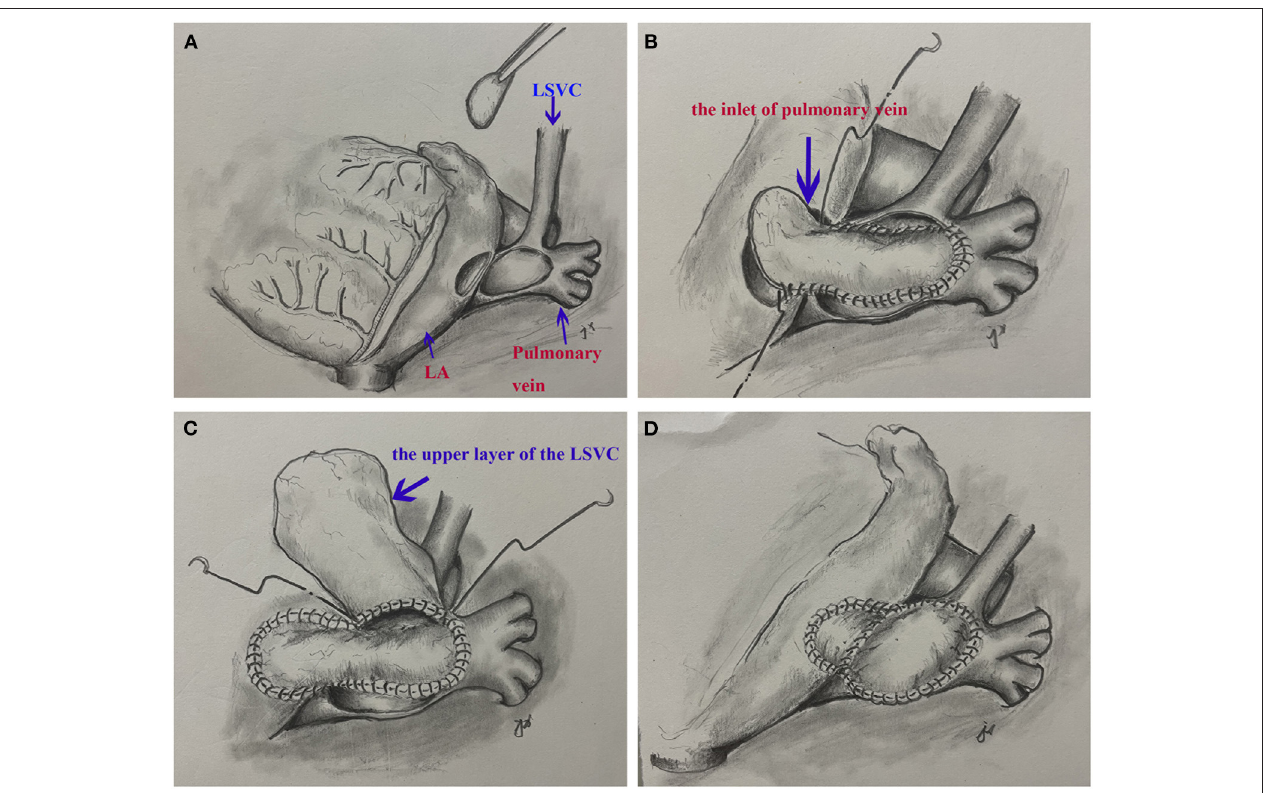
FIGURE 2 | A surgical view of the double-decker technique. (A) Resection of a portion of left atrium and cut the confluence of the left superior vena cava and pulmonary veins. (B) The autologous pericardial baffle is sutured by guiding the blood flow of the left pulmonary vein to the surgical entrance of the adjacent left atrium. (C) The other pericardium creates another upper tunnel, directing blood flow from the left superior vena cava to the dilated coronary sinus. (D) The completed double-decker